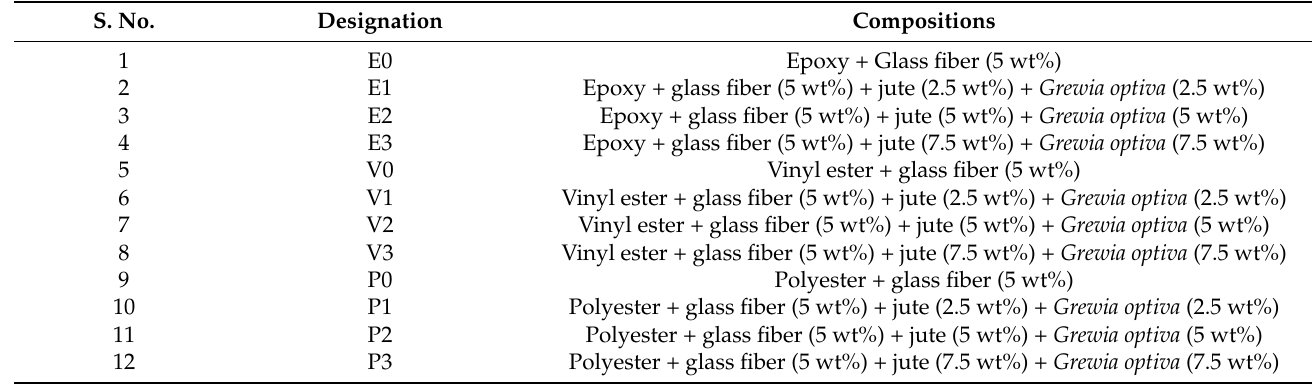
Table 1. Composition of fabricated composites.